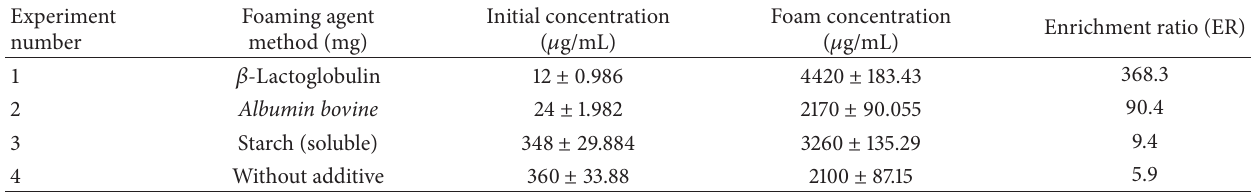
Table 3: Enrichment ratios and start, foam, and residual extract concentrations (mg/mL) of Glycyrrhiza glabra with 𝛽 -lactoglobulin, albumin bovine, and starch (soluble) preferred as foaming agents and without